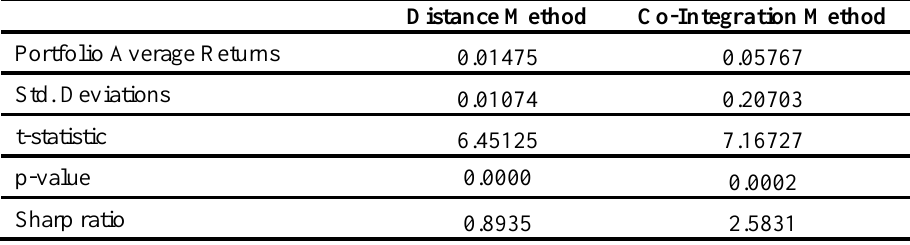
Table.5. Comparison of Distance and Co-Integration